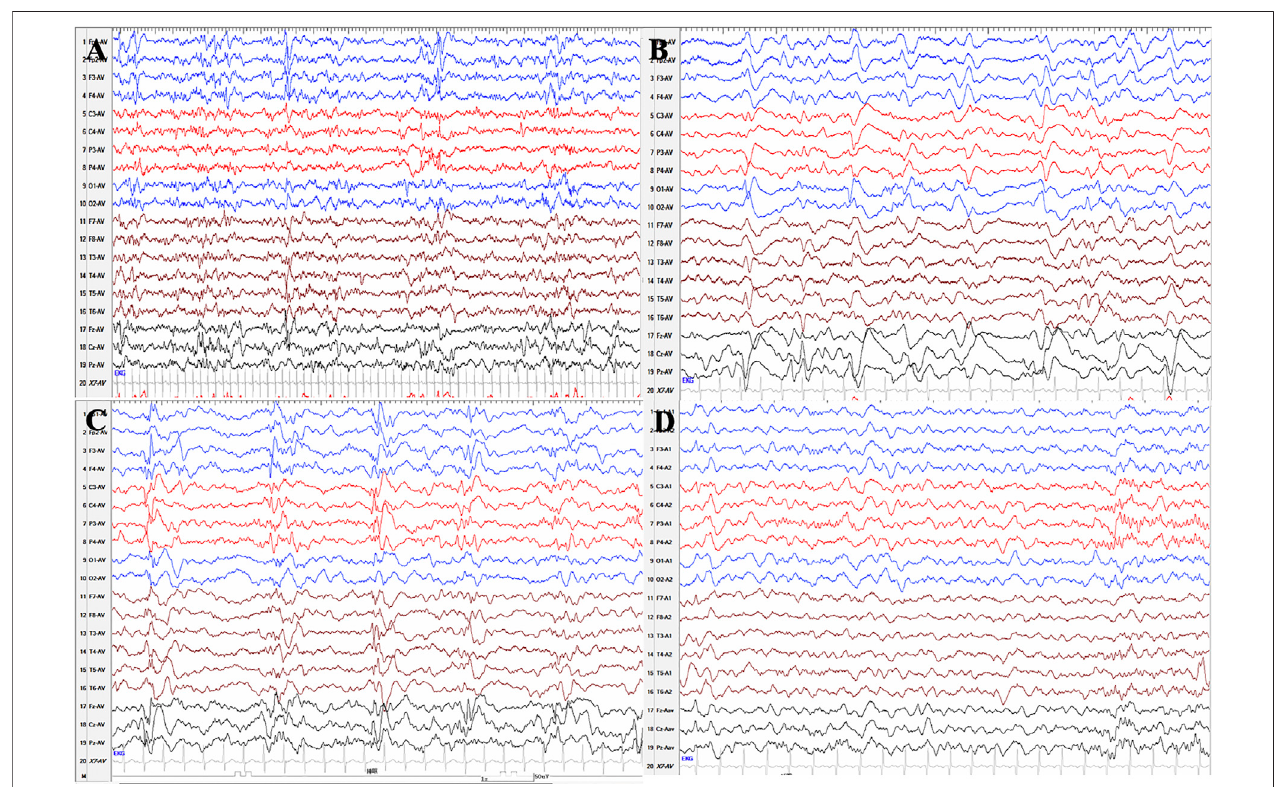
FIGURE 4 | Serial EEG results of patient 11 with PLPBP de fi ciency. (A) and (B) EEGs showed multifocal sharp waves and fast waves and widely positive sharp waves in central, parietal, and midline areas at 26 days after birth before epileptic spasms occurred without pyridoxine therapy. (C) EEG showed multifocal and generalized spikes, spike and slow waves, and fast rhythm at the age of3 months without pyridoxine therapy. (D) EEG showed normal after seizures were controlled by pyridoxine for nearly 4